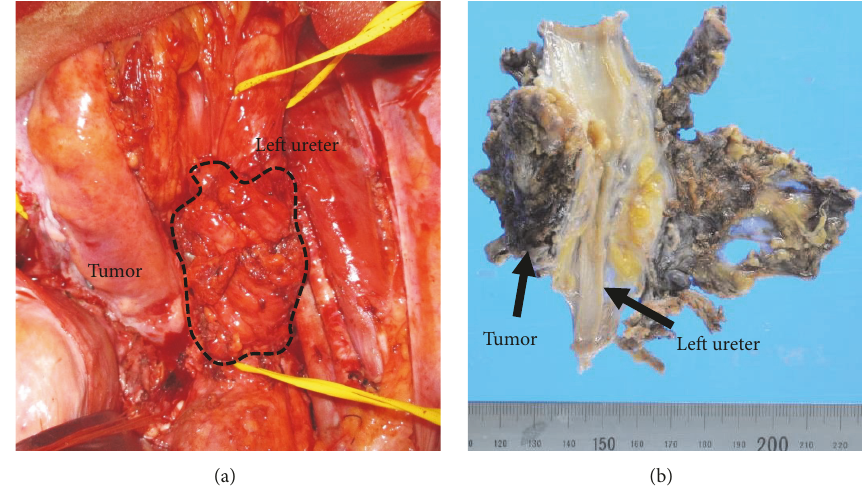
Figure 2: (a) The pelvic mass encasing with left ureter observed in surgery and (b) macroscopic the resected tissue after